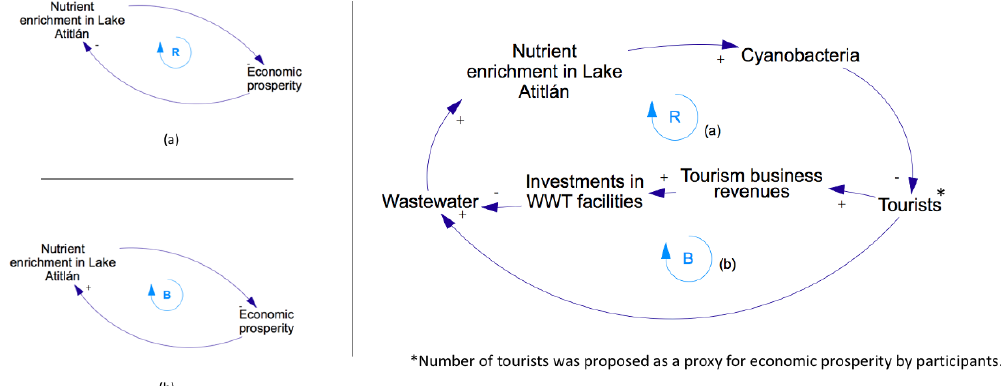
Figure 11. The relationship between nutrient enrichment in Lake Atitlán and economic prosperity – reinforcing loop (a) and balancing loop (b). The two loops on the left represent generalized relationships of the two loops on the right, mentioned and agreed upon by partic- ipants. The two contradicting views underpinning the two generalized relationships (loops (a) and (b) on the left) were elicited by different stakeholder groups. The delineation of both relationships shows that all potentially valid points can be represented explicitly in the model, which reinforces the point of inclusivity. Quantification would show which of the two loops dominates the model’s